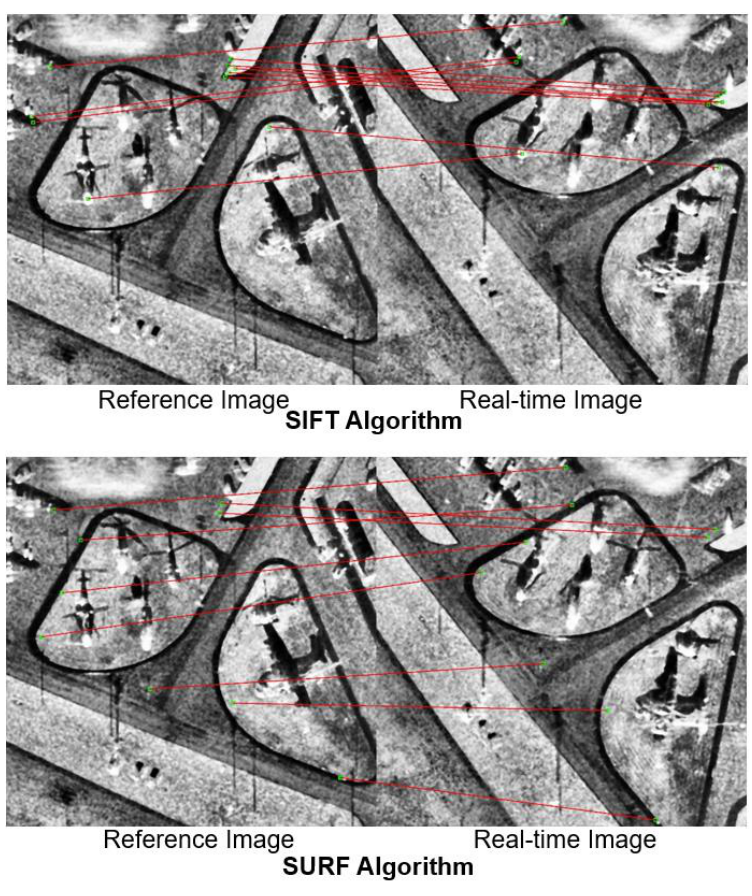
Figure 4. Image matching between SAR images. Table 1. Credibility of Image Matching between SAR images.